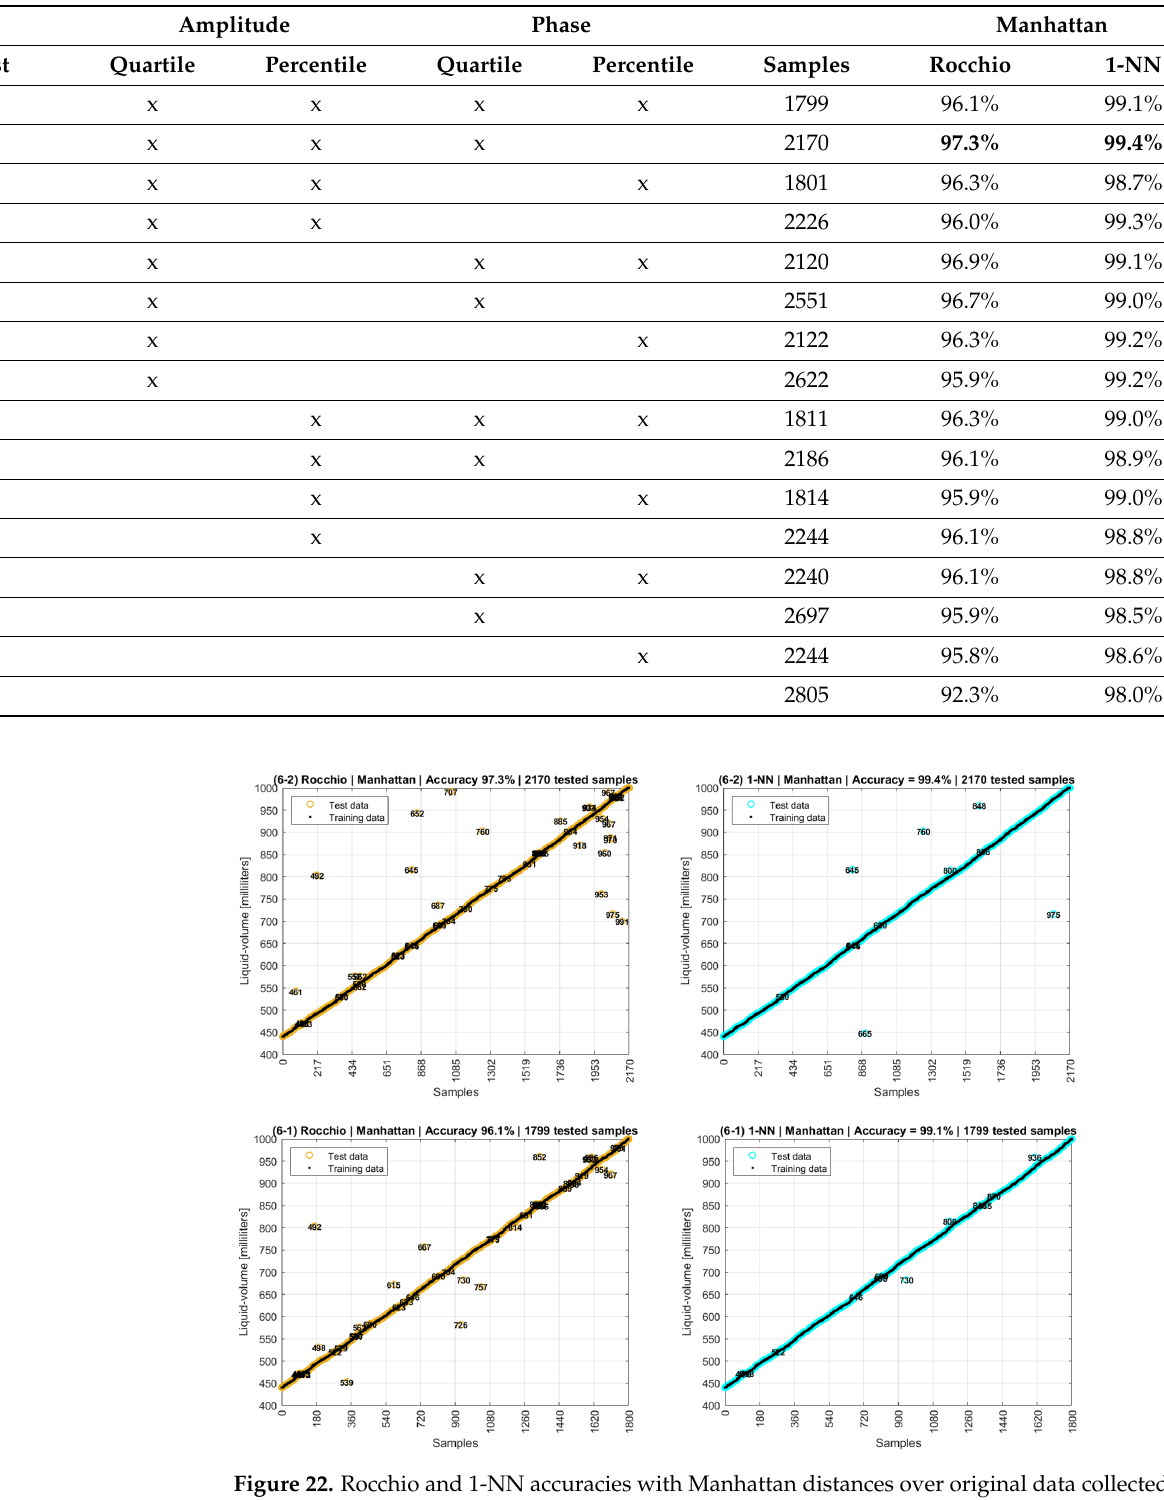
Table 2. Sixth scenario results for Rocchio and 1-NN with Manhattan and outlier selections.